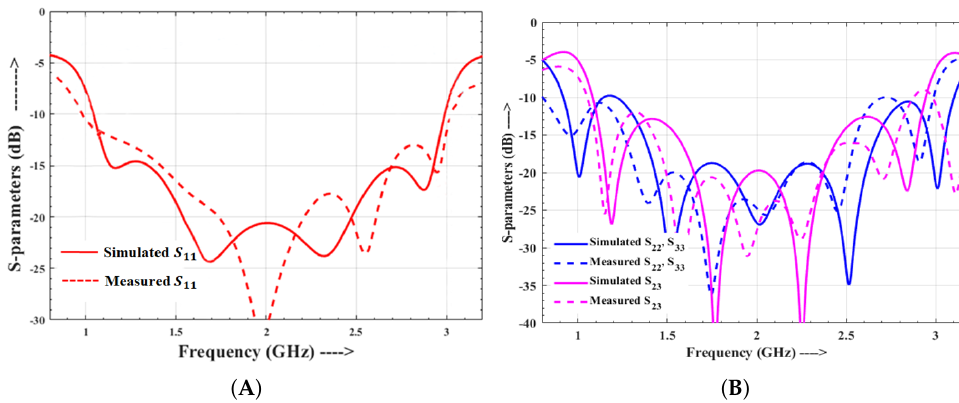
Figure 25. EM vs. Measured S-parameters for ( A ) S 11 ; ( B ) S 23 , S 22 for θ c = 55 ◦